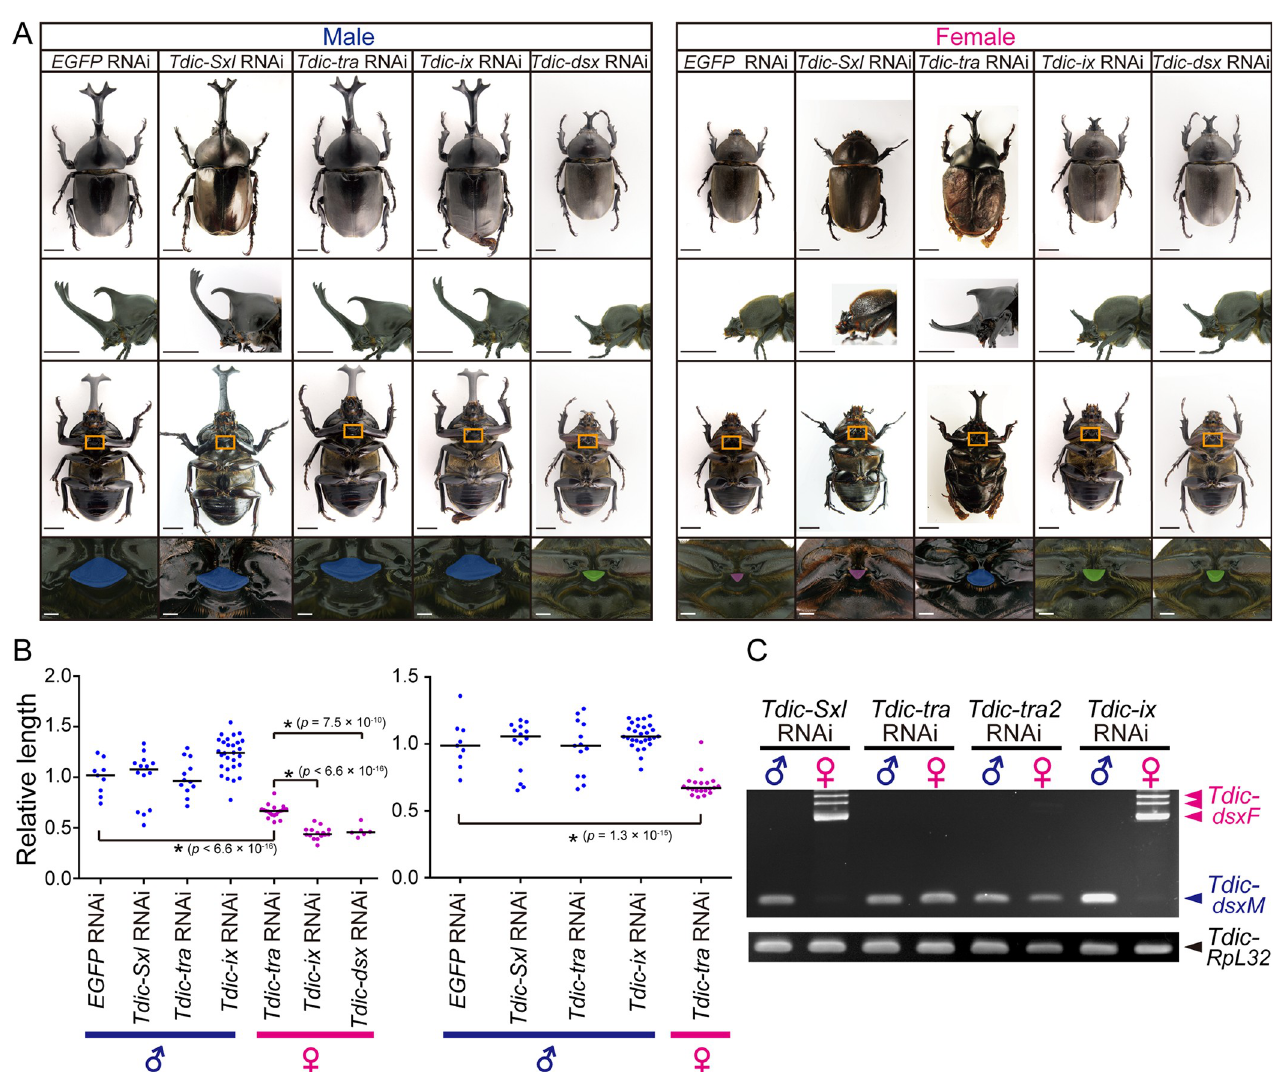
Fig 3. RNAi-mediated loss-of-function phenotypes of the sex determination genes. (A) Representative individuals in each RNAi treatment in males (the left half) and females (the right half). Each dsRNA was injected into last-instar larvae. The negative control RNAi treatment ( EGFP dsRNA) showed no morphological defects. The upper row, the dorsal views of adults; the second row, the lateral views of a head and a prothorax in adults; the third row, the ventral views of adults; the forth row, magnified views of orange squares (IPP, intercoxal process of prosternum) in the third row. Scale bars are 1 cm in the upper three rows and 1 mm in the fourth row. (B) Quantification of the relative head and thoracic horn length in RNAi-treated individuals. Relative head and thoracic horn length in RNAi-treated males and females are plotted in the blue dots and the magenta dots, respectively. The relative horn lengths were standardized by dividing the horn length by the body size in each RNAi treated individual and by the mean horn length of the EGFP RNAi-treated males. Differences in horn length among individual RNAi treatments were compared using Brunner-Munzel test. These p-values were adjusted by the Bonferroni correction. Asterisks denote significance: n.s., p > 0.05; � , p < 0.05. (C) Sex-specific splicing of Tdic-dsx in RNAi treatments targeting Tdic-Sxl , Tdic-tra , Tdic-tra2 and Tdic-ix . Blue arrowheads, male specific splicing patterns. Magenta arrowheads, female specific splicing patterns. Tdic-RpL32 was used as an internal control for